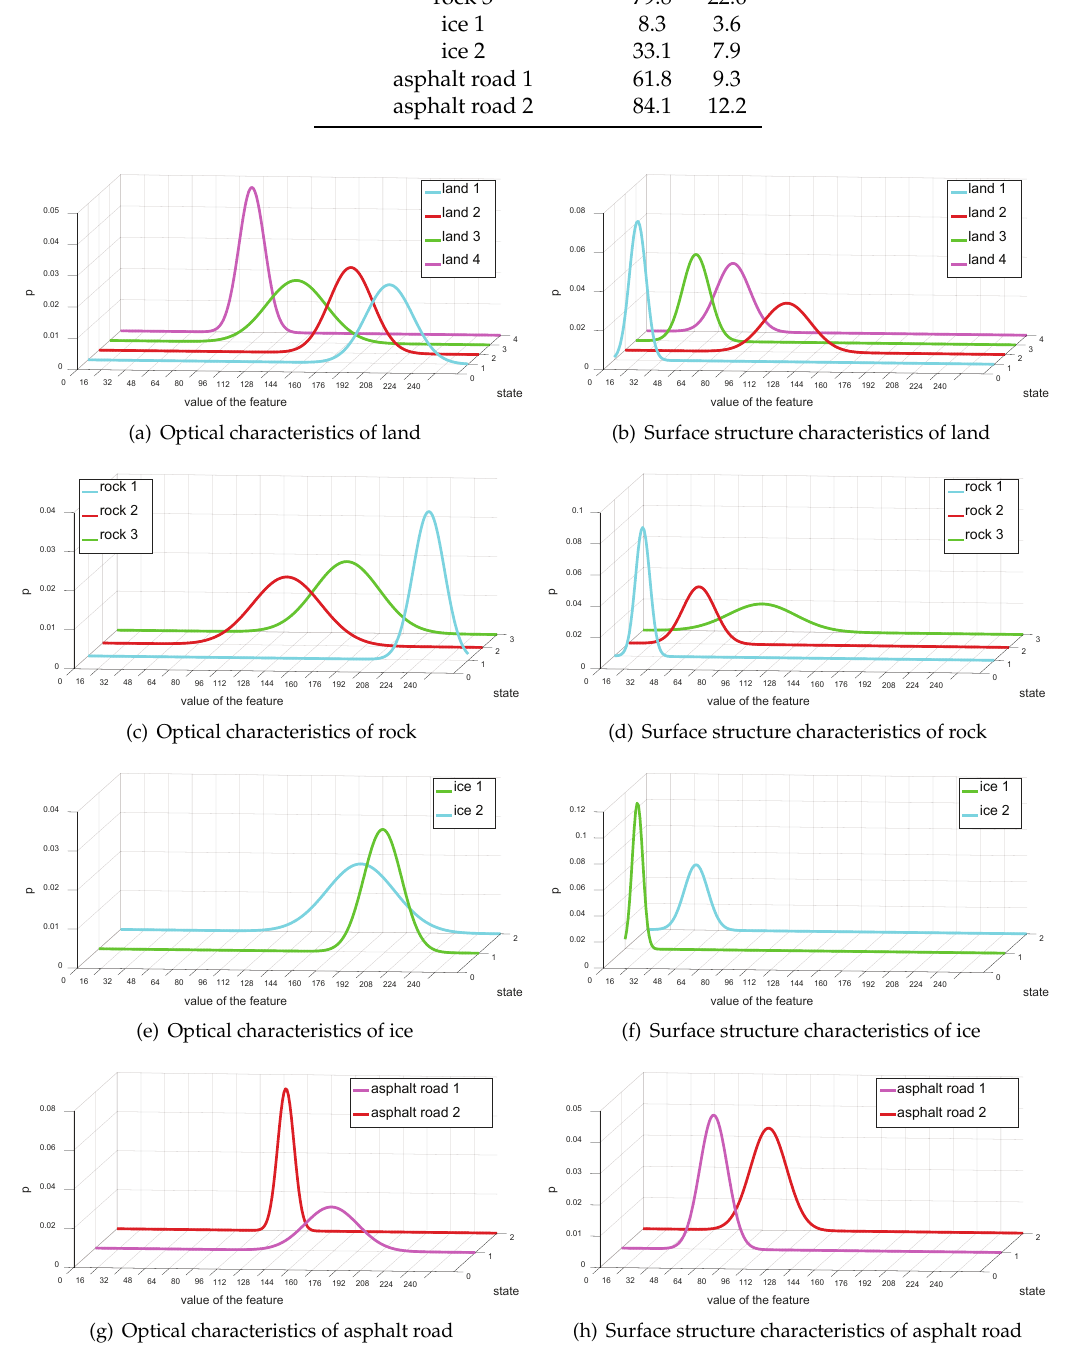
Figure 11. The Gaussian distributions of optical characteristics and surface structure characteristics of land, rock, ice and asphalt road in different